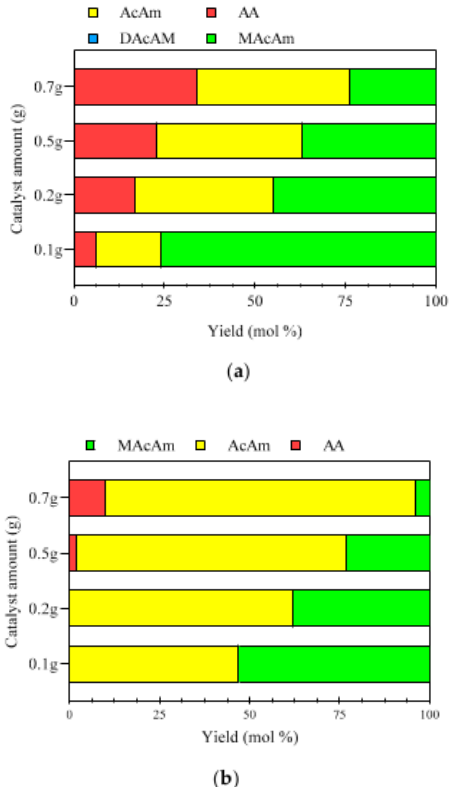
Figure 9. ZVI@ORMOSIL catalyzed reduction of DAcAm ( a ) and MAcAm ( b ) at increasing catalyst weight. [substrate] = 8.8 mM, [NaBH 4 ] = 0.176 M, reaction medium: